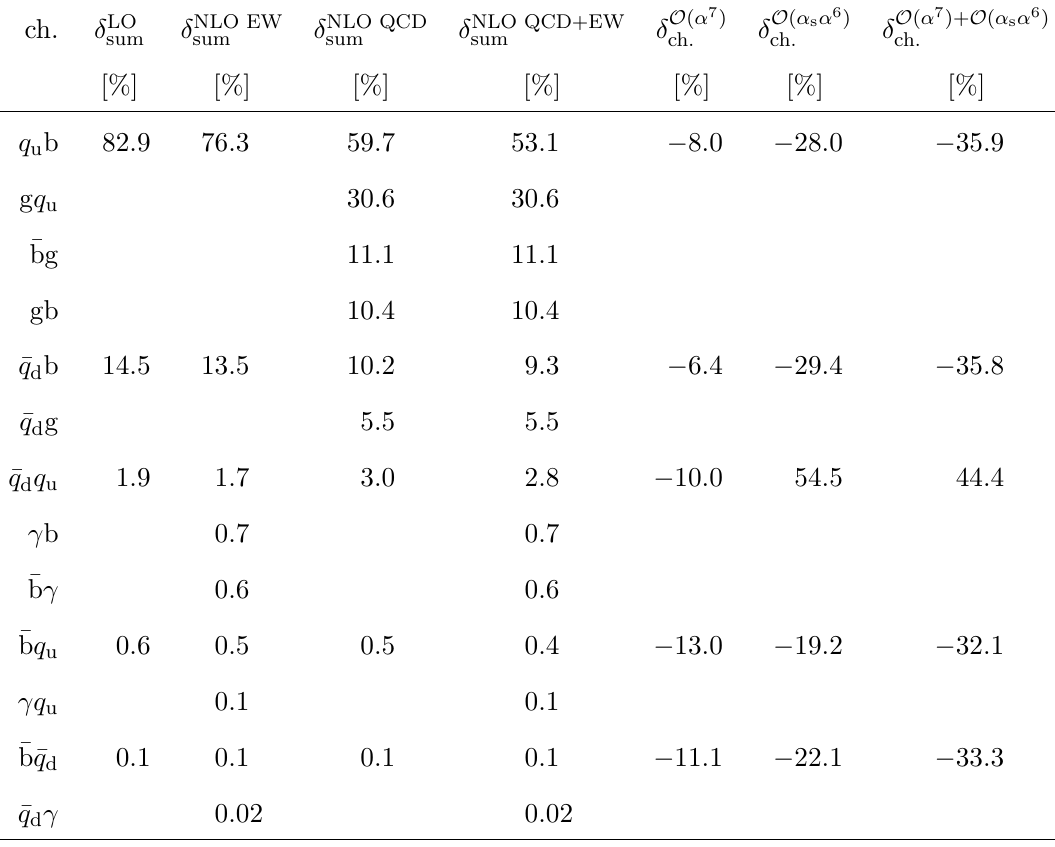
Table 2. Relative corrections for the integrated cross sections in the default setup for contributing channels summed over final states (column 1). The quantities δ eq. (3.2), give the contribution of each channel at LO, NLO EW, NLO QCD, and NLO QCD+EW relative to the sum of all channels at LO. The quantities δ show the EW, QCD, and QCD+EW corrections (without LO) relative to the LO of the same